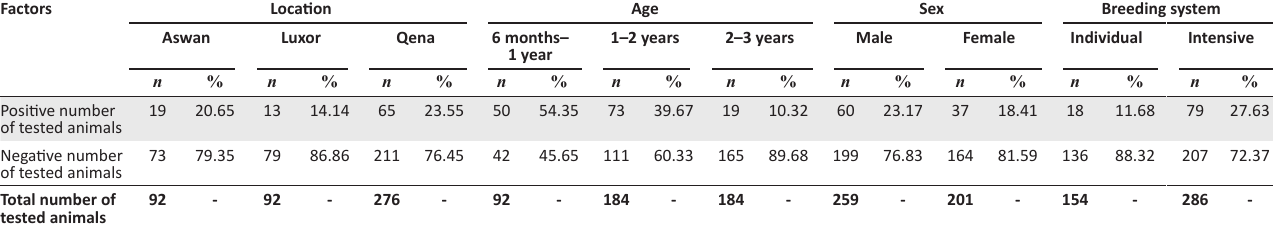
TABLE 3: Rift Valley Fever infection in animals regard to location, age, sex and breeding system. Factors